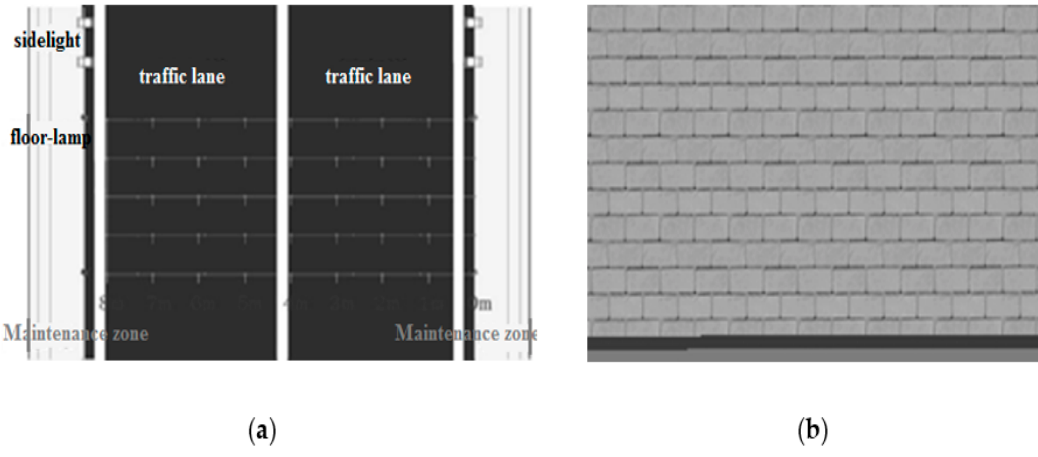
Figure 1. ( a ) Tunnel pavement simulation and ( b ) wall material simulation.